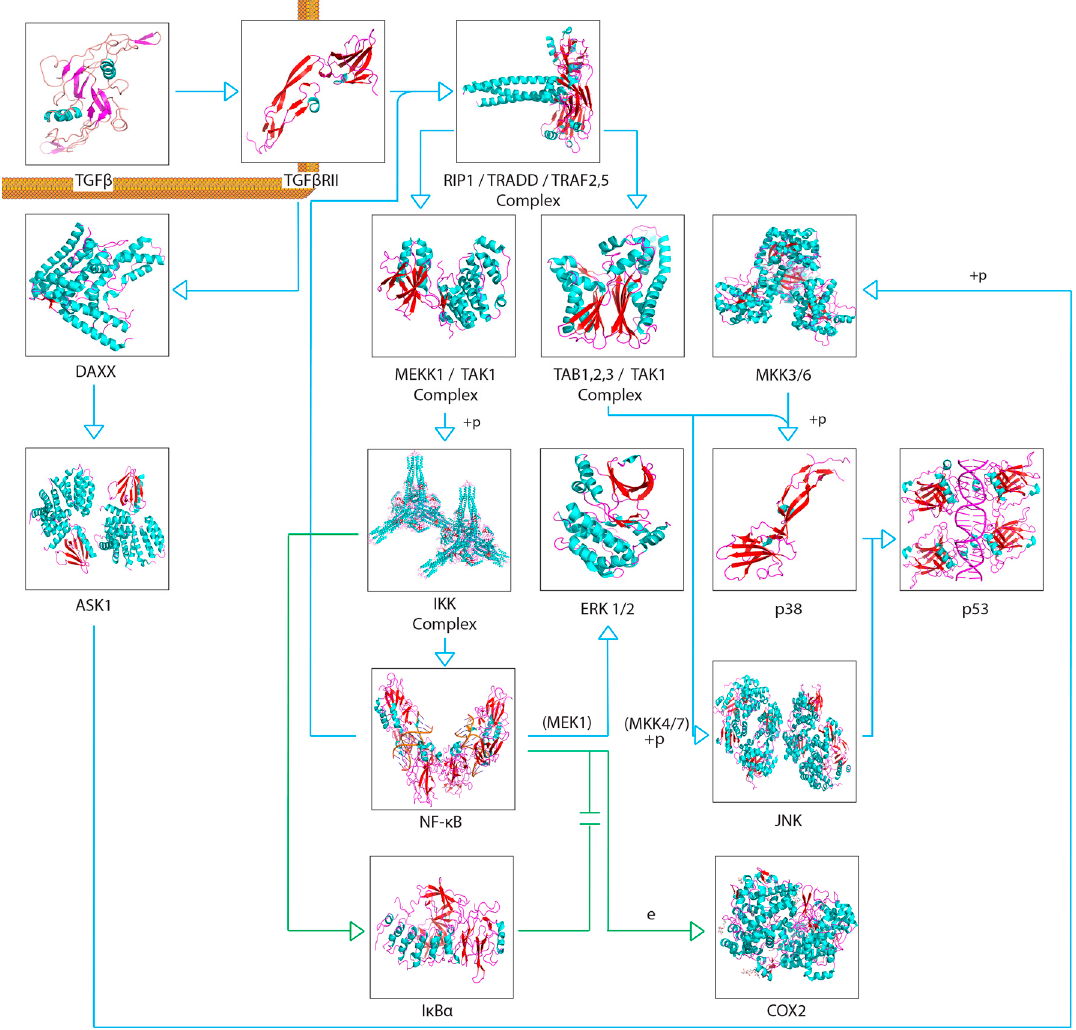
Figure 3. The classical MAPK pathway and a simplified NF-kB pathway. This pathway is of particular interest because of TGF β ’s ability to induce signalling through receptor recognition and signal amplification. The pathway is also of interest because of its endpoints, namely activation of p53 and various cytokines.